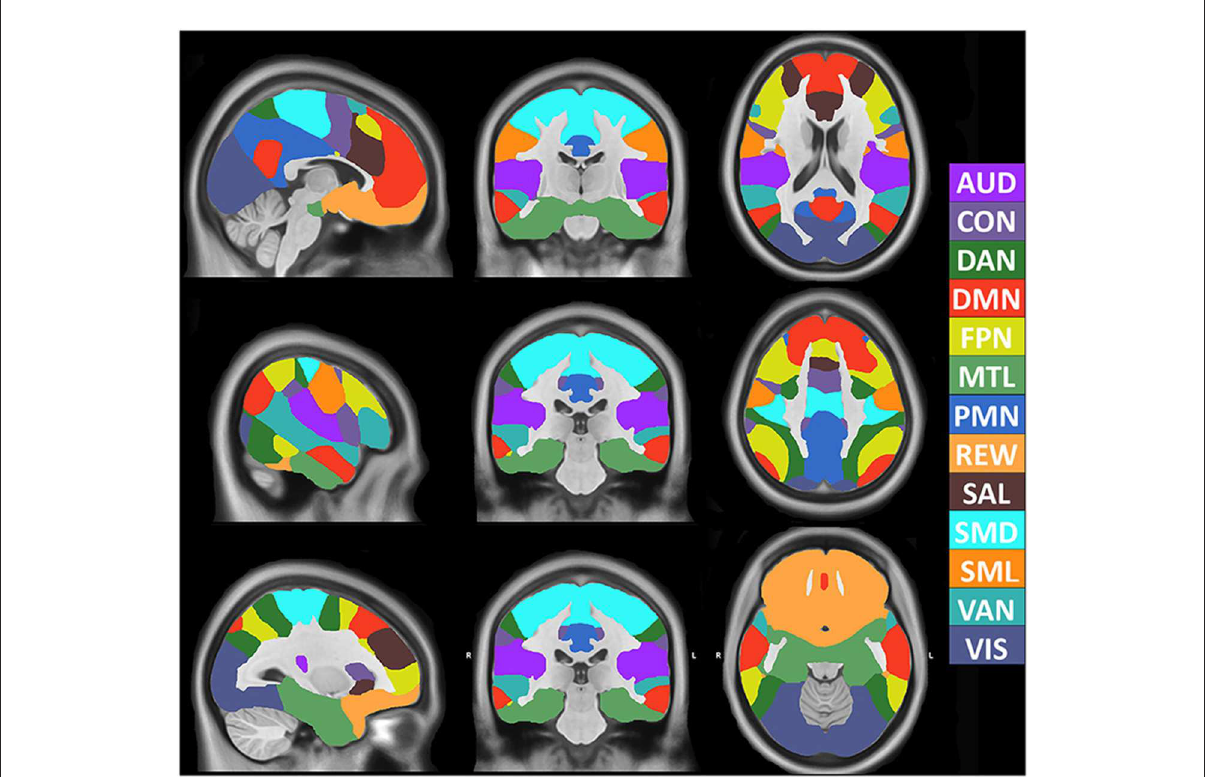
FIGURE1 Volumetric segmentation of resting state networks based on maximum probability produced by the 3DCNN averaged across 2010 participants. SMD, dorsal somatomotor; SML, lateral somatomotor; CON, cinguloopercular; AUD, auditory; DMN, default mode; PMN, parietal memory; VIS, visual; FPN, frontoparietal; SAL, salience; VAN, ventral attention; DAN, dorsal attention; MTL, medial temporal; and REW,